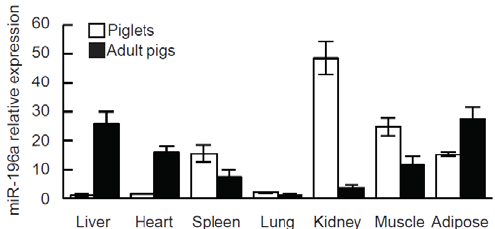
Figure 1. Expression of miR-196a in swine tissues from 3-day-old piglets and 180-day-old adult pigs. Total RNA was isolated from seven different tissues including heart, liver, spleen, lung, kidney, skeletal muscle and subcutaneous adipose tissue, and the expression of miR-196a was analyzed by qPCR and normalized to U6.